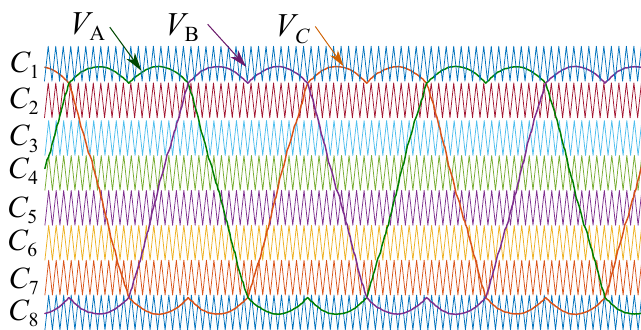
Figure 1. Block diagram of the 9-level inverter drive.